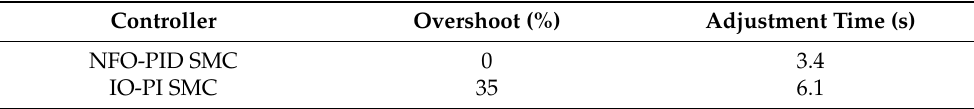
Table 3. Performances of the